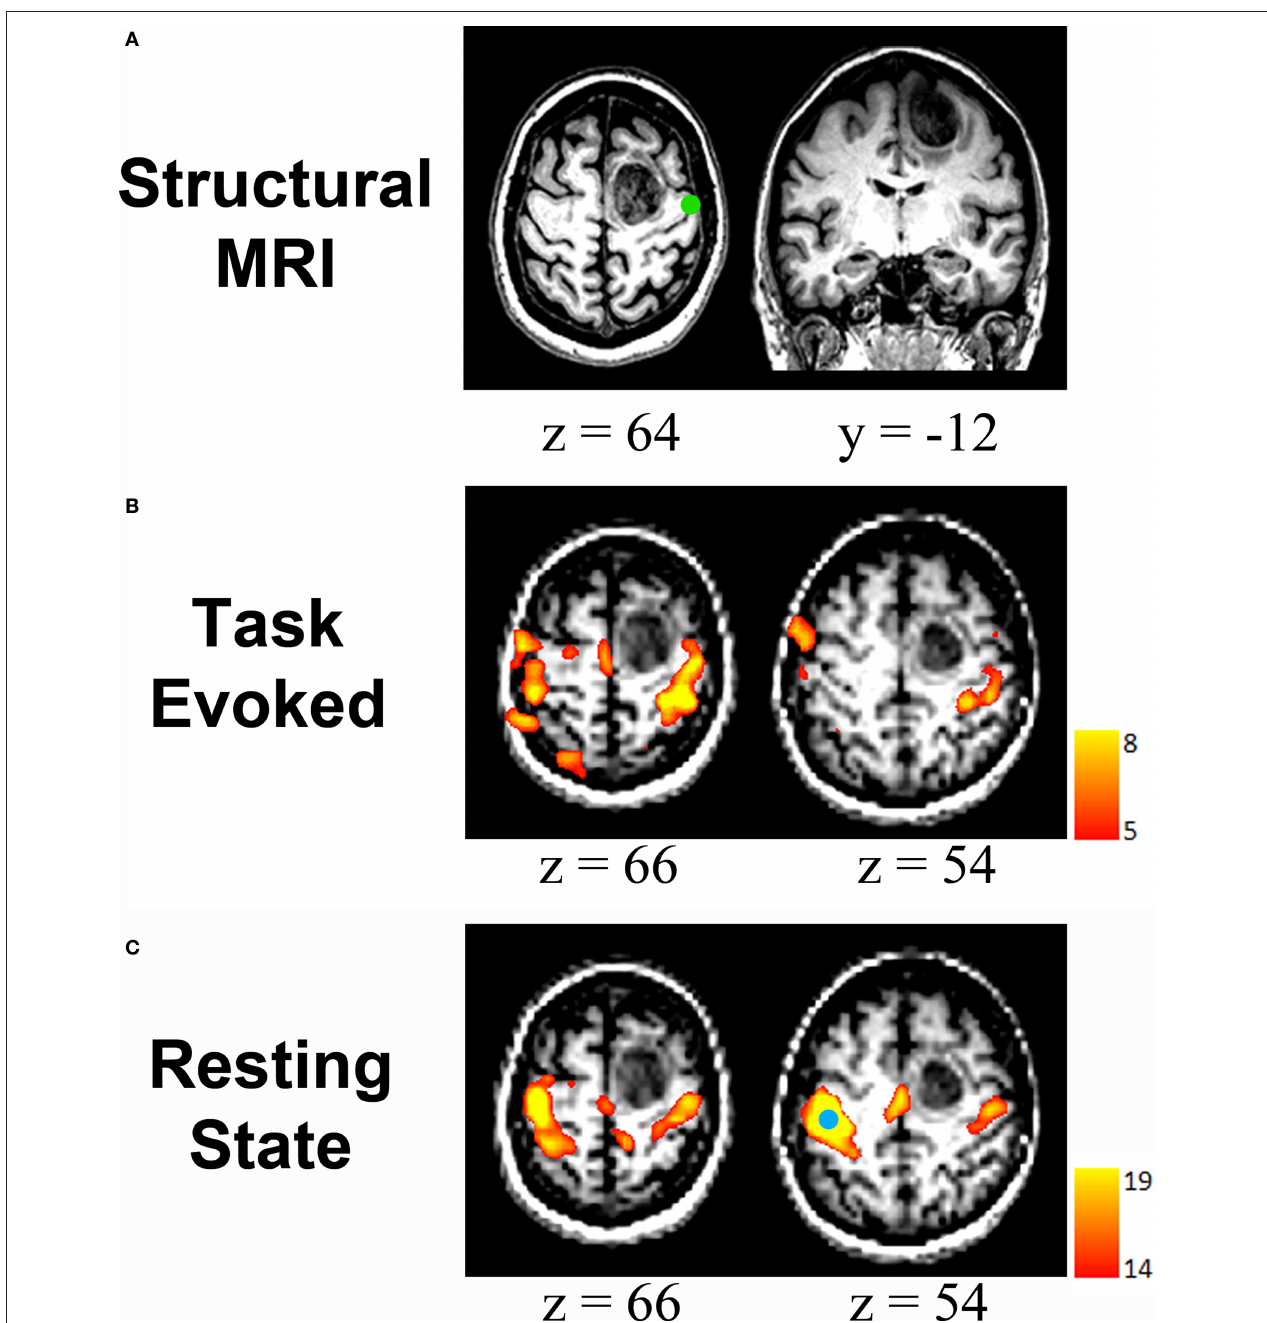
FIguRe 4 | Resting state fcMRI in pre-operative brain mapping: (A) Structural MRI scan showing a mass in the right frontal cortex. Green circle represents the location of ipsilateral hand response to intra-operative cortical stimulation. (B) Task-related mapping showing activity within the sensorimotor network but also small responses in parietal cortex that are seemingly